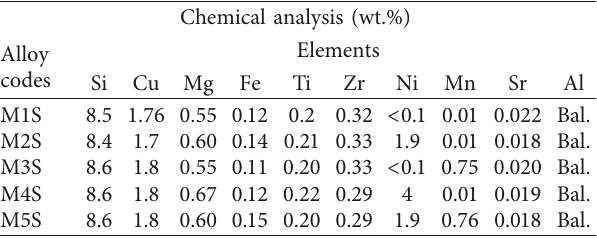
Table 2: Heat treatment procedures and parameters applied to alloys studied. Heat treatment procedures and parameters Heat